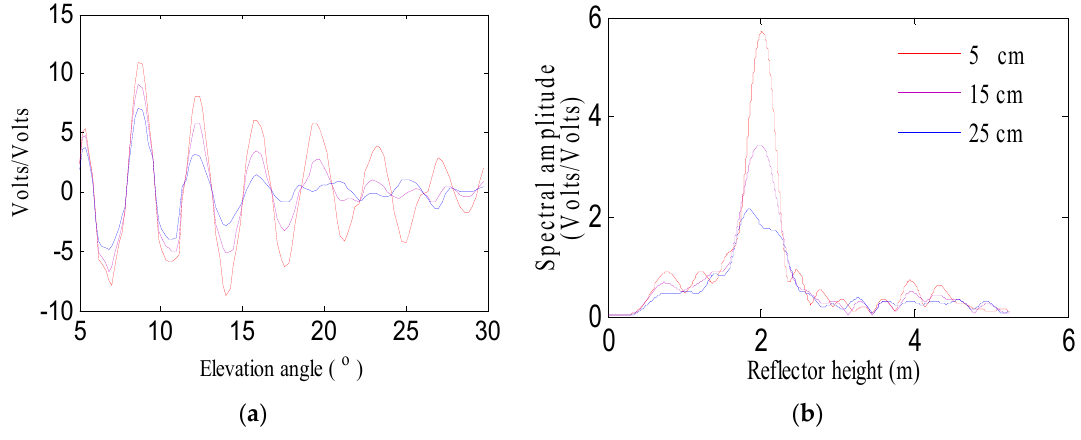
Figure 8. Comparison of simulated L2P SNR modulations at different surface roughness. ( a ) Multipath modulations with different surface roughness; ( b ) Lomb–Scargle periodogram of multipath pattern.